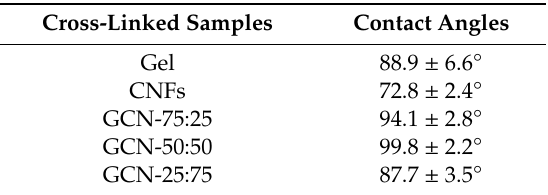
Table 3. Summary of the contact angles of the cross-linked pure polymers and the Gel–CNF